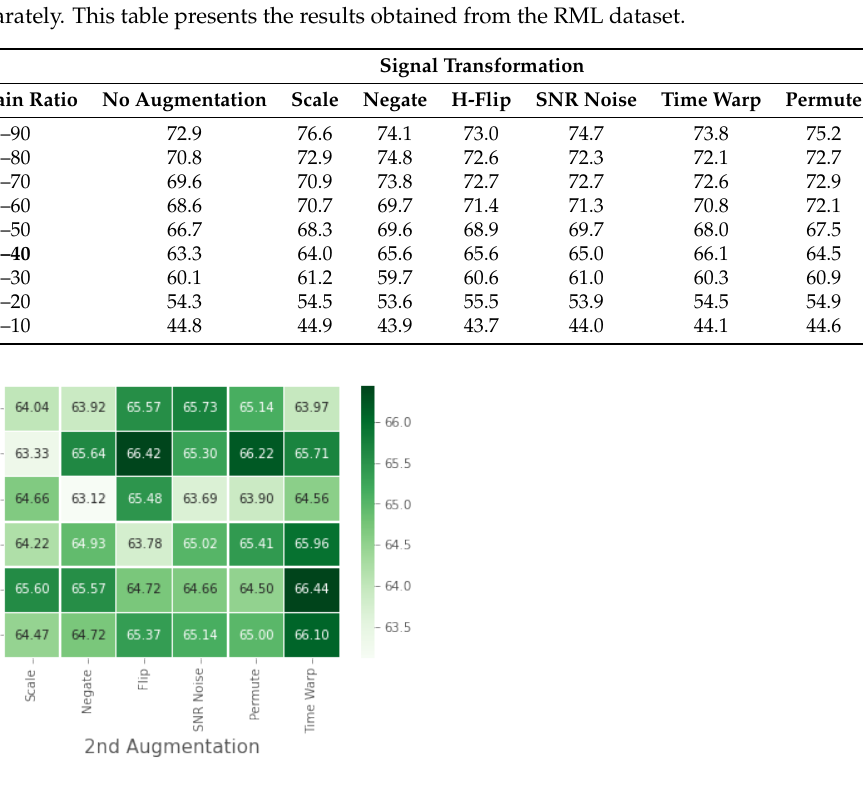
Figure 8. Contrastive SSL evaluation of RML under single or composition of data augmentations. Di- agonal values correspond to single augmentations, while off-diagonals correspond to the composition of two augmentations applied sequentially.